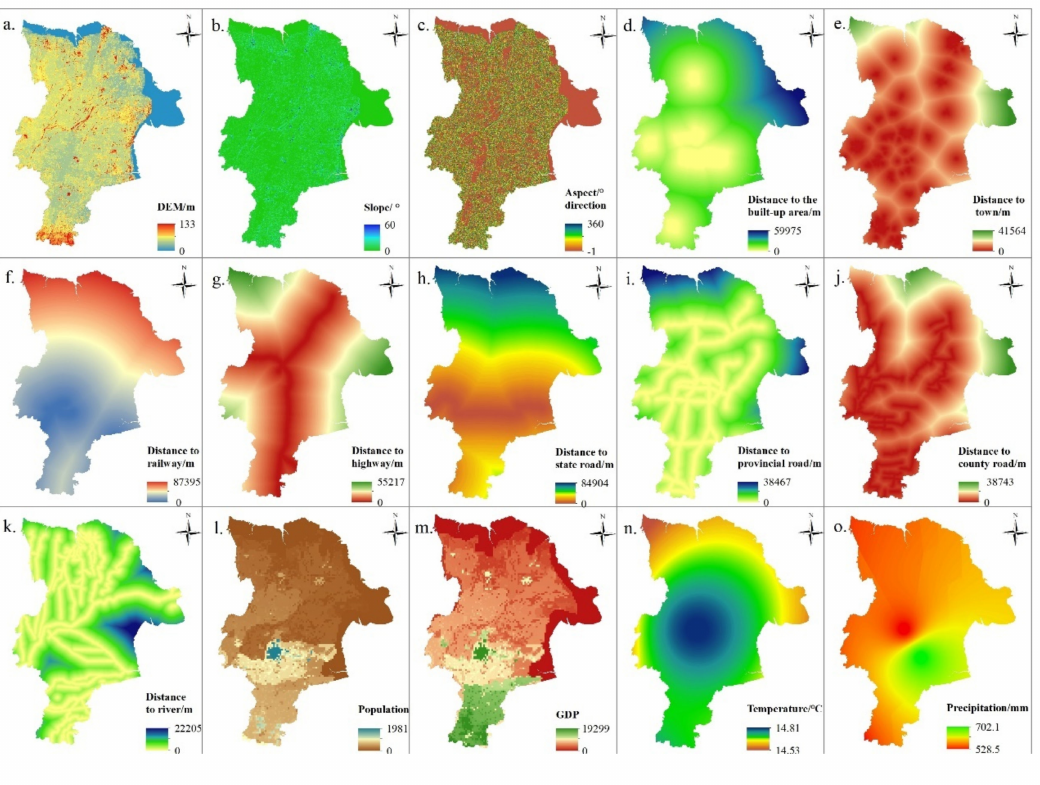
Figure 2. Driving factors of land use in Dongying city (( a ) elevation; ( b ) slope; ( c ) aspect; ( d ) distance to the built-up area; ( e ) distance to town; ( f ) distance to railway; ( g ) distance to highway; ( h ) distance to state road; ( i ) distance to provincial road; ( j ) distance to county road; ( k ) distance to river; ( l ) population distribution; ( m ) GDP distribution; ( n ) annual average temperature; ( o ) annual average